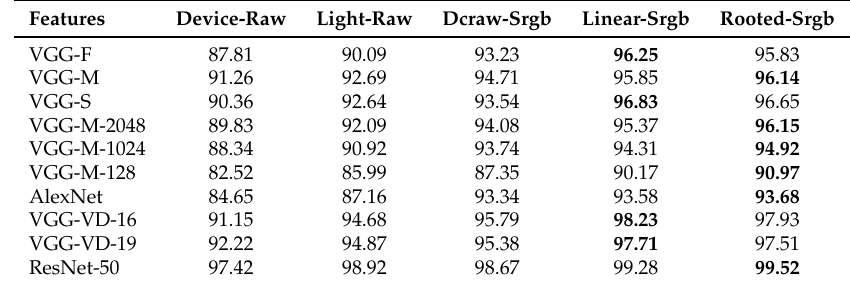
Table 2. Classification accuracy obtained by each visual descriptor combined with each model, the best result is reported in bold.